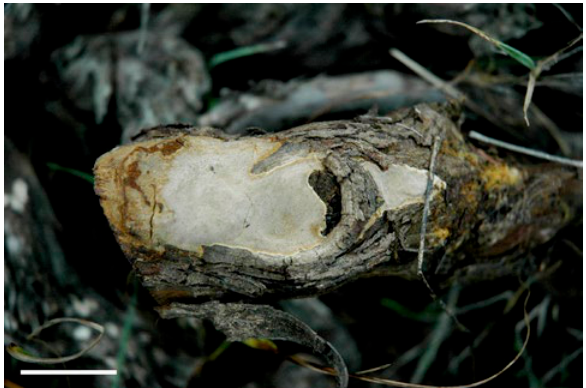
Figure 5. Resupinate fruitbodies of Fomitiporia punctata in a grapevine plant var. “Tempranillo”. Bar = 2 cm. Photo - graph: V.